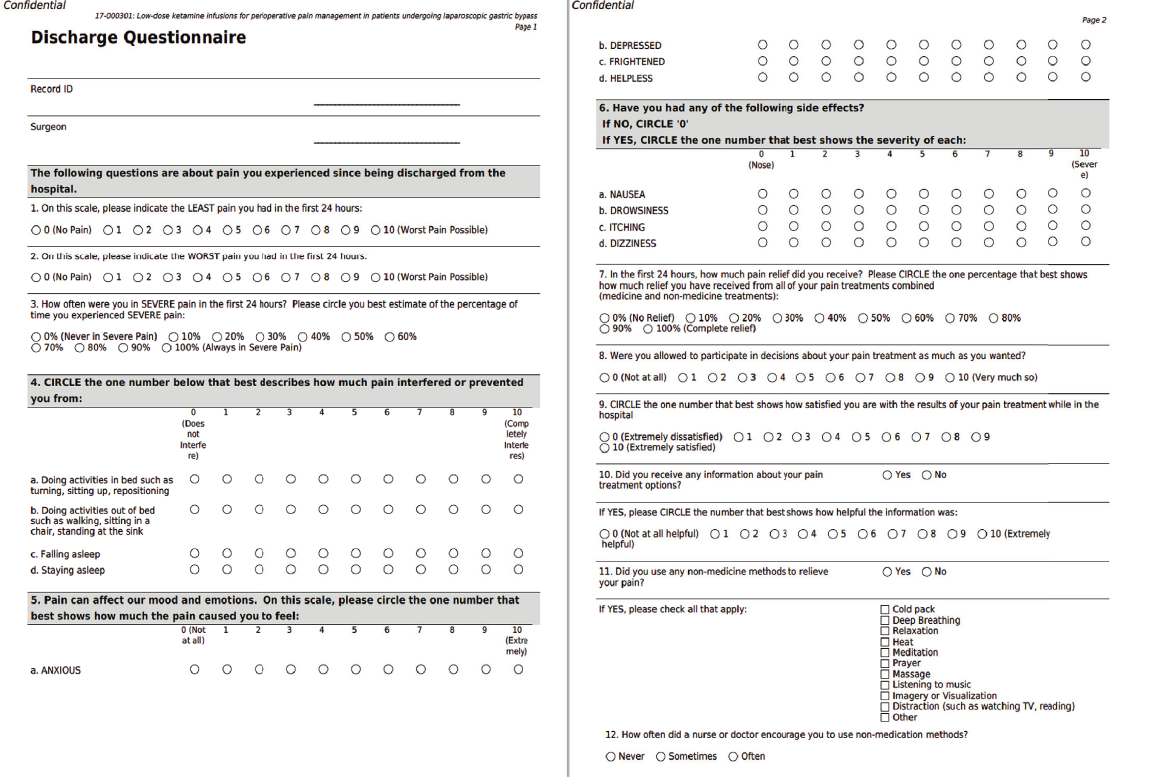
Figure 2: The postop questionnaire/survey given to patients at their first postop follow-up appointment since being discharged from the hospital.